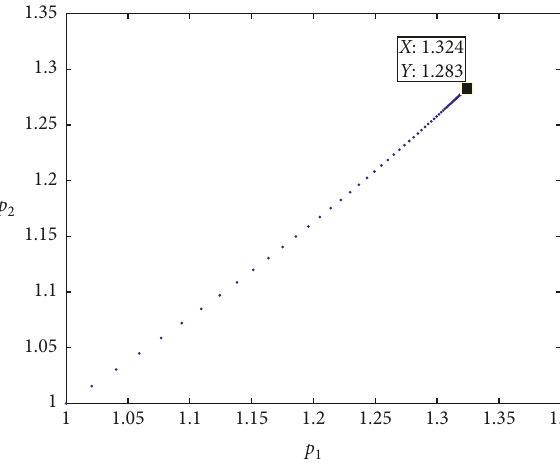
Figure 5: The Nash equilibrium price p